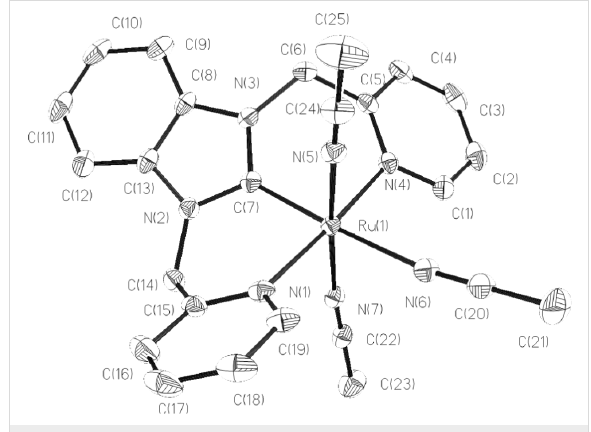
Figure 3: Structural view of 3 showing 50% thermal ellipsoids. All hydrogen atoms and PF 6 − were omitted for clarity. Selected